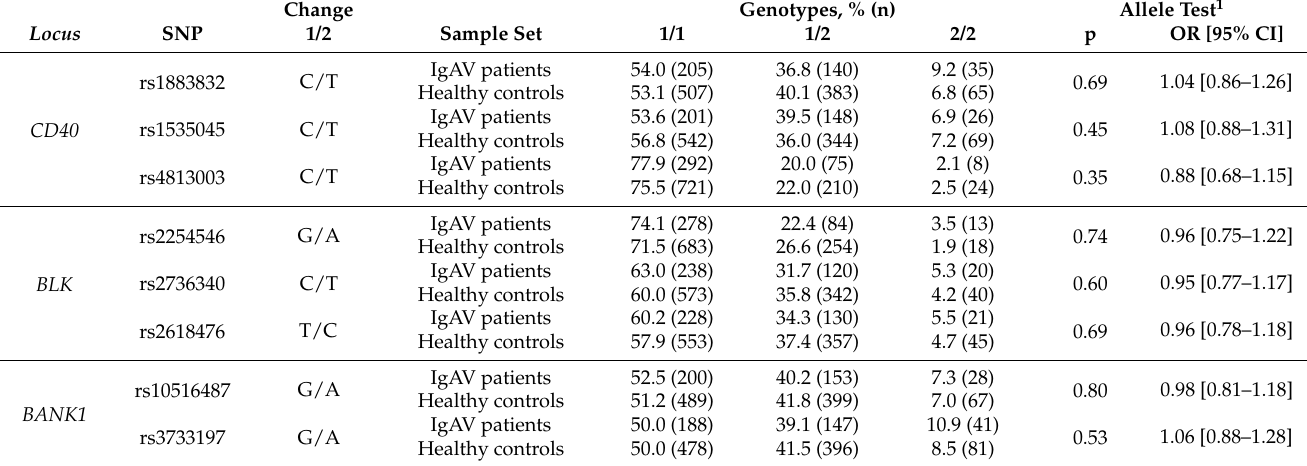
Table 2. CD40, BLK and BANK1